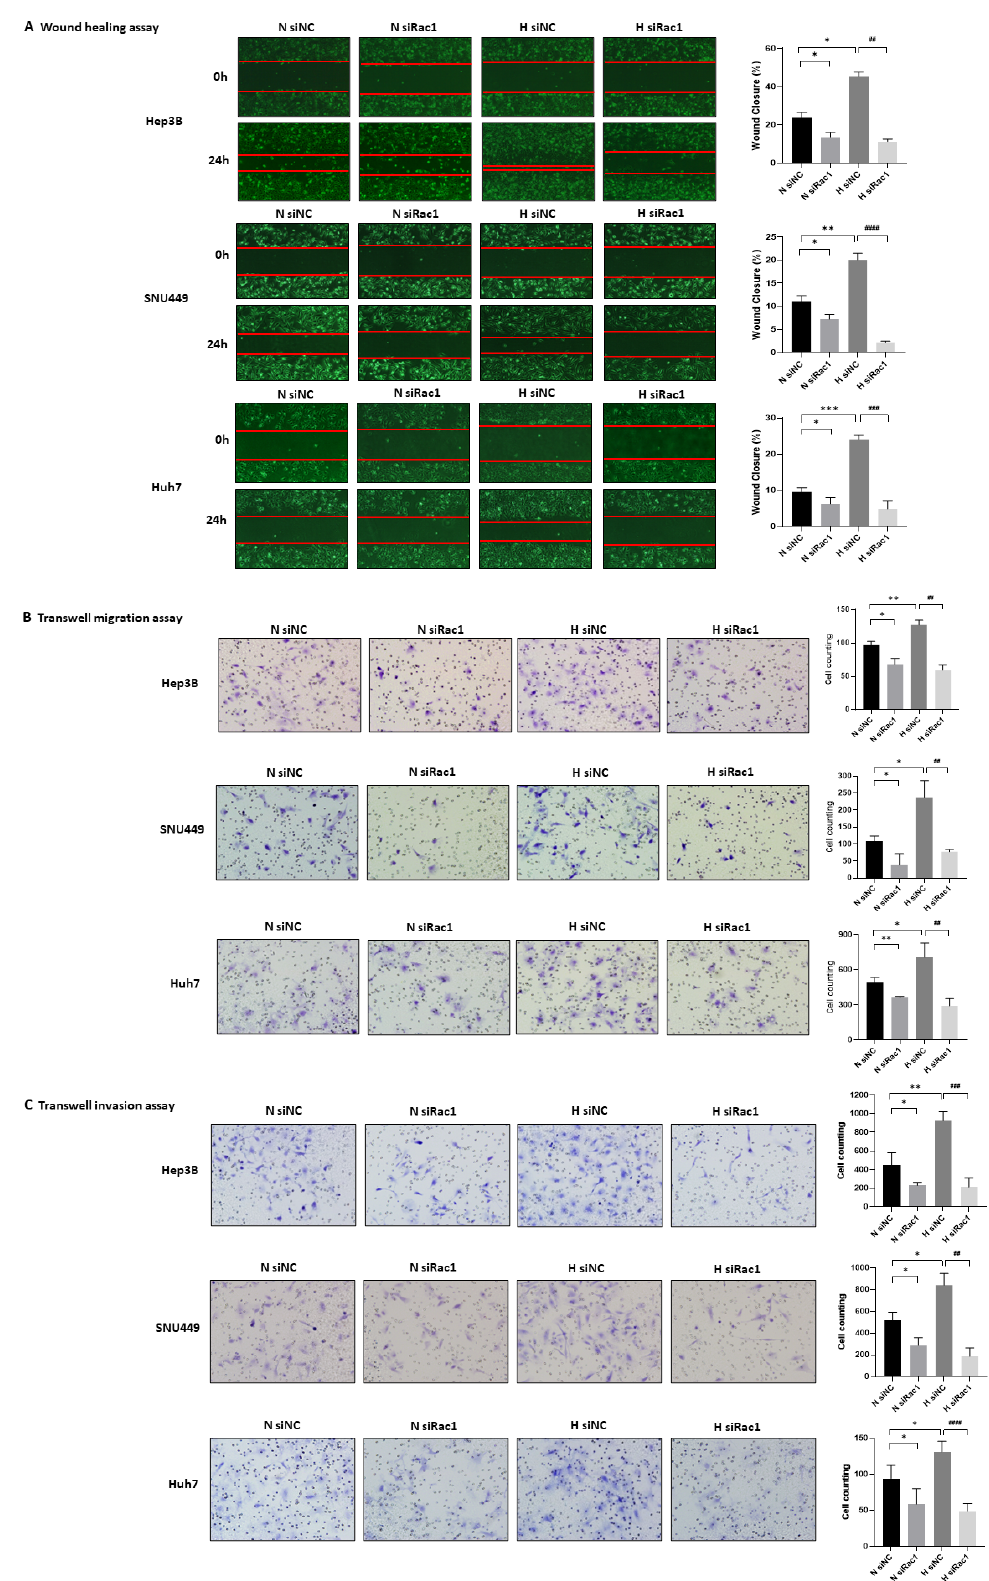
Figure 4. Rac1 knockdown suppresses the migration and invasion of hypoxia-exposed HCC cells. Hep3B, SNU449, and Huh7 cells were transfected with Rac1 siRNA and exposed to